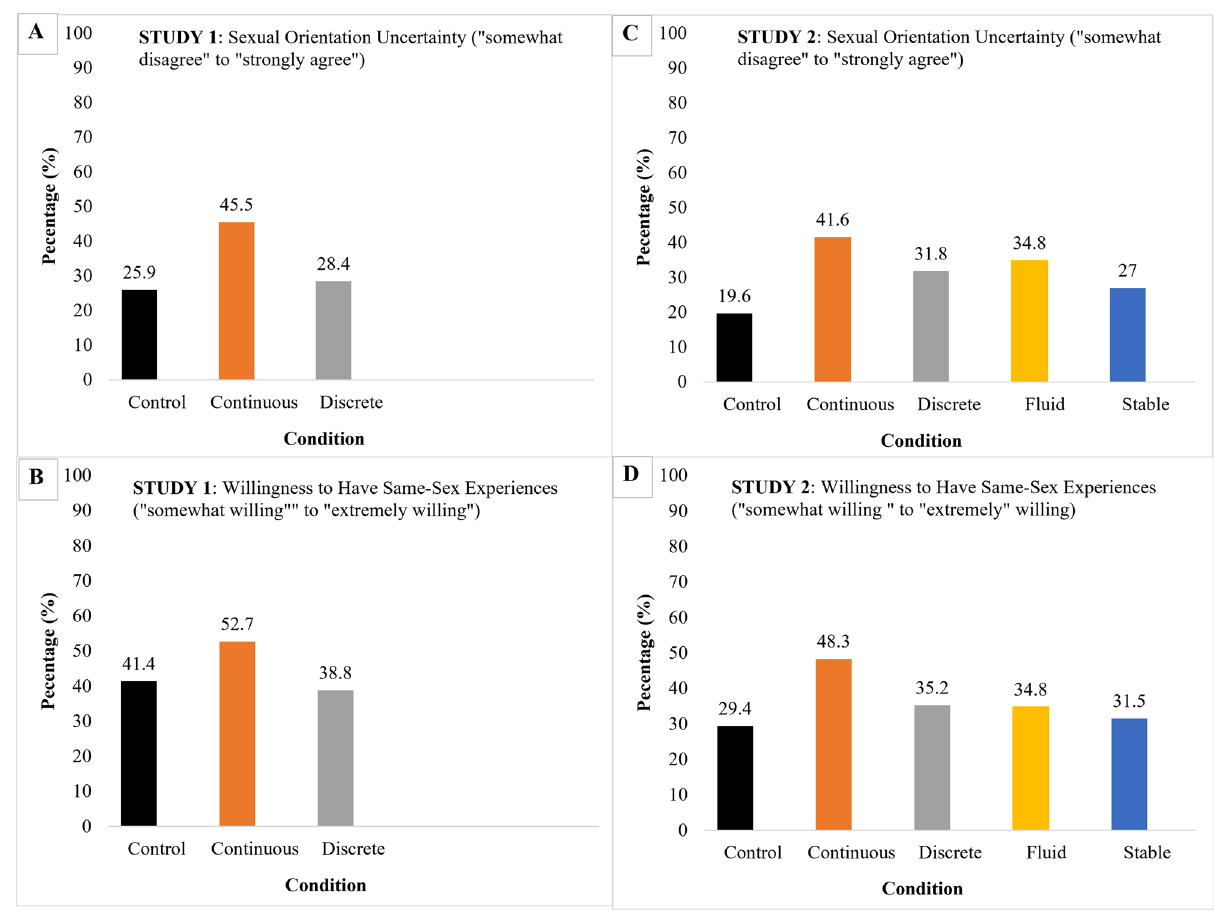
Figure 3. Post-manipulation sexual orientation uncertainty and willingness to have same-sex experiences in Study 1 and Study 2. For ( A ) and ( B ), Y-axis represents the percentage of participants in each condition who reported some-level of sexual orientation uncertainty (somewhat disagree [2] to strongly agree [4]). For ( C ) and ( D ), Y-axis represents the percentage of participants in each condition who report some level of willingness to have same-sex experiences (somewhat [2] to extremely willing